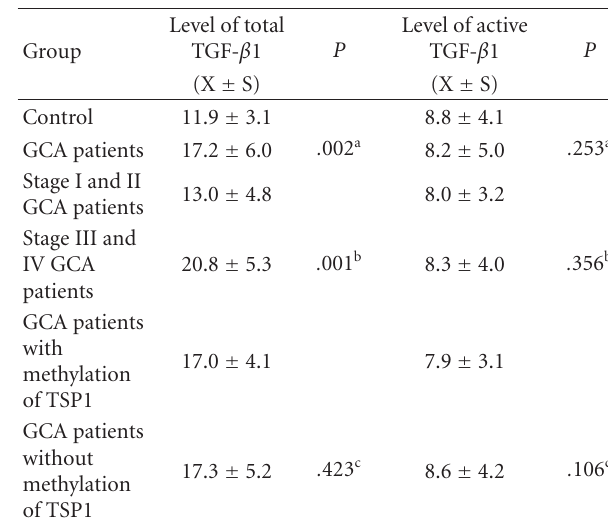
Table 4: The level of TGF- β 1 in GCA patients ( μ